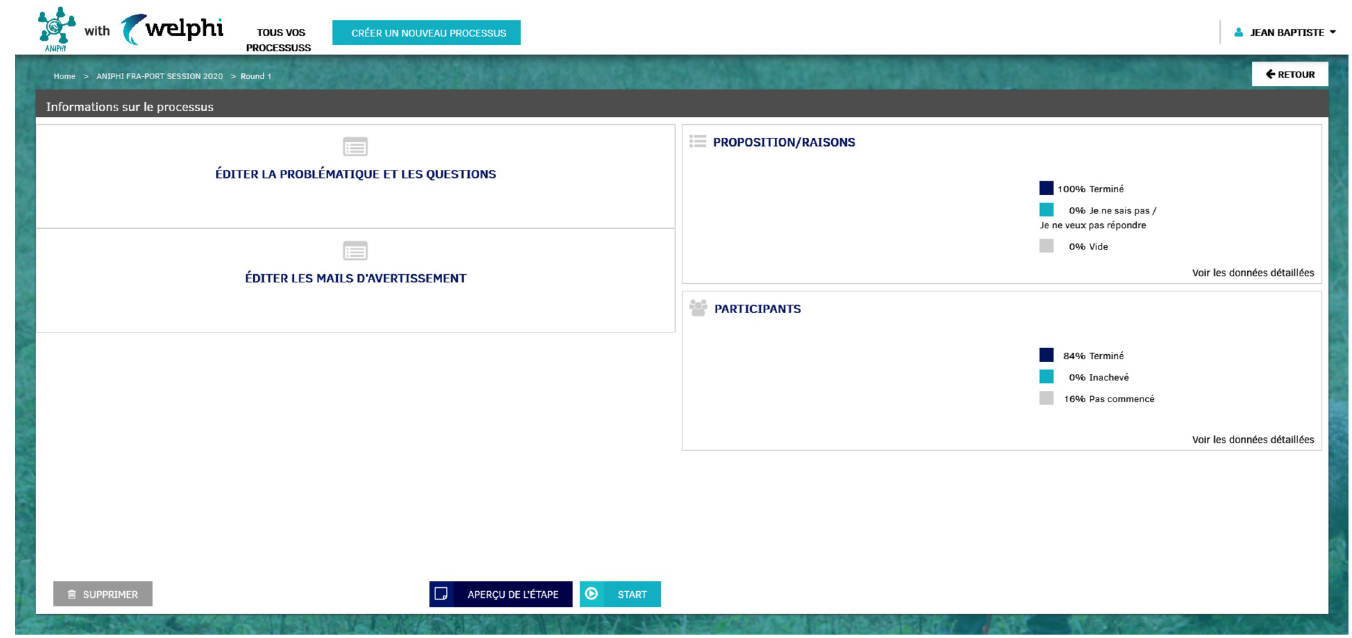
Fig 3. Round details management, for rounds 1 and 4 (user: